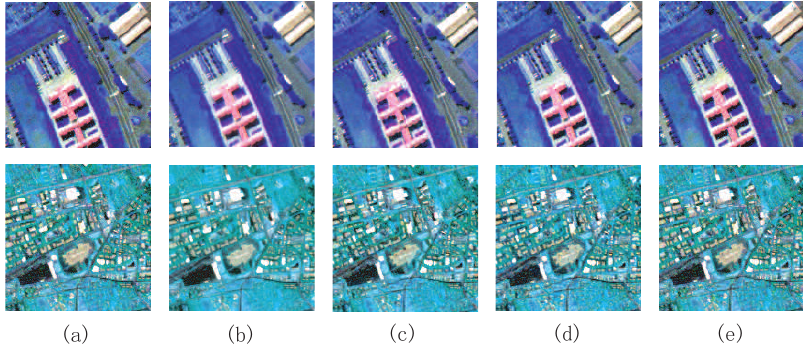
Figure 7. The reconstructed images by such fusion methods as ( a ) CNMF, ( b ) BSR, ( c ) HySure, ( d ) CSTF and ( e ) JSMV-CNMF for (top row) Pavia University and (bottom row) Moffett datasets, respectively.